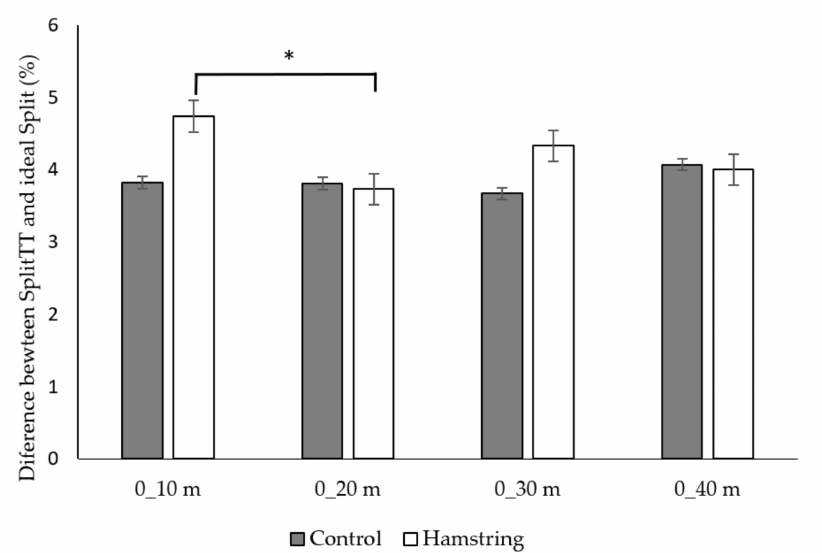
Figure 3. Percentage difference between Split TT and Ideal Split: percentage difference between the time to run a specific number of splits and the time if these splits were run as the best of them. Control: Subjects without previous hamstring injury; Hamstring: Subject with previous hamstring injury. * Significant difference between 0–10 m and 0–20 m in the hamstring group considering the first 20 m of the sprints ( p < 0.005).